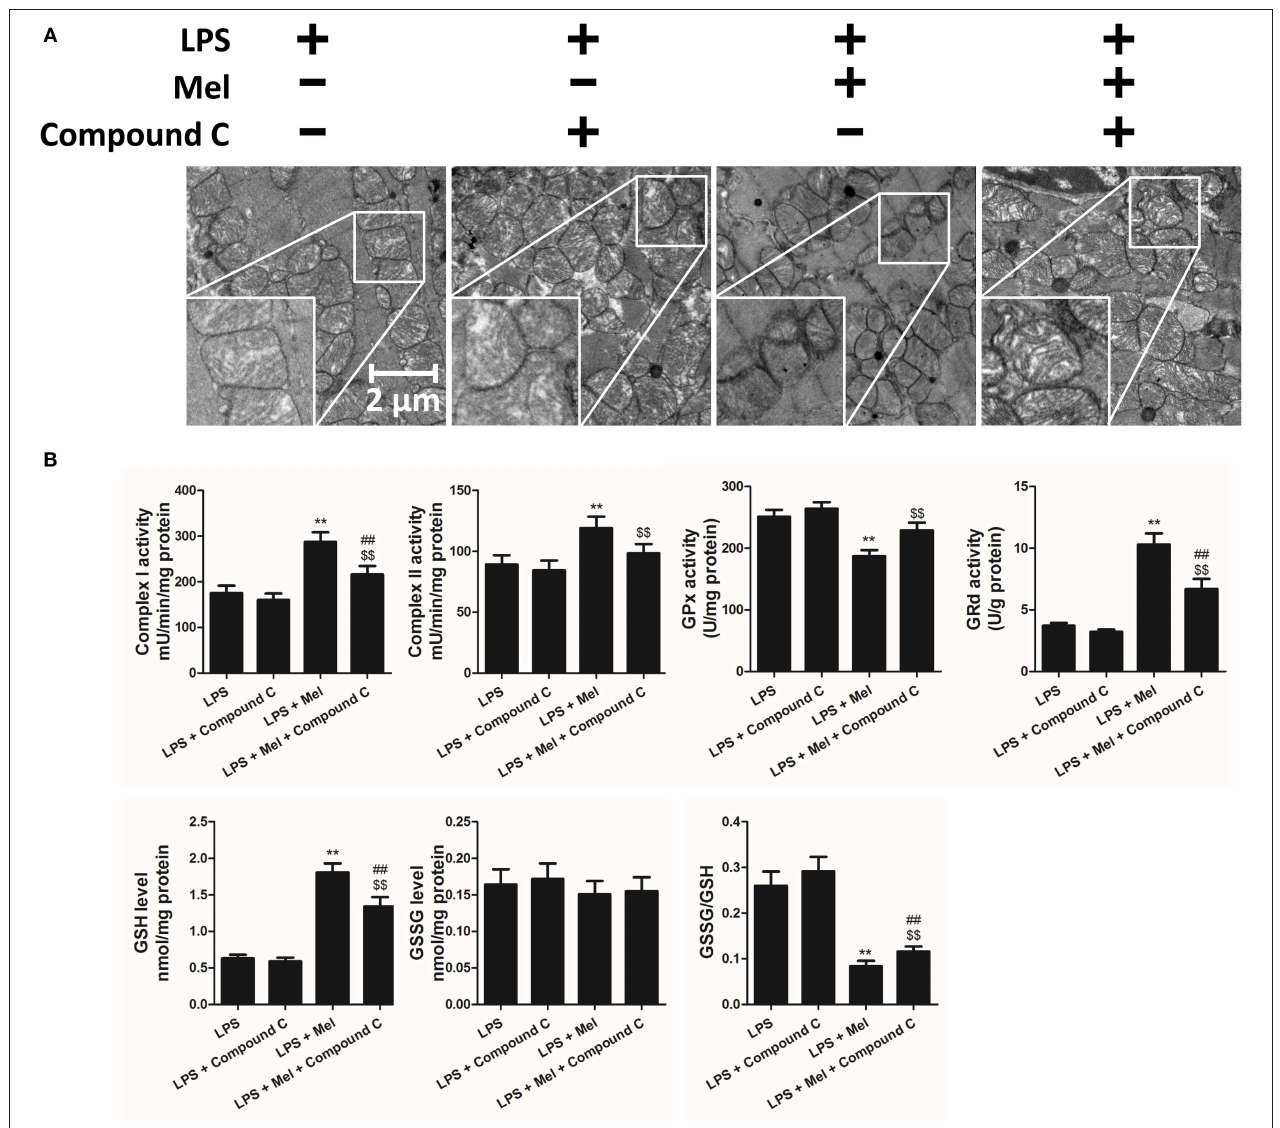
FIGURE 6 | Effects of Compound C treatment on mitochondrial morphology and function. (A) Representative images of mitochondrial morphology. (B) Quantitative analysis of mitochondrial Complex I, Complex II, GPx, and GPd activity, and GSH, GSSG levels. n = 6 ** P < 0.05 vs. the LPS group, ## P < 0.05 vs. the LPS + melatonin group, $$ P < 0.05 vs. the LPS + Compound C group. Mel,